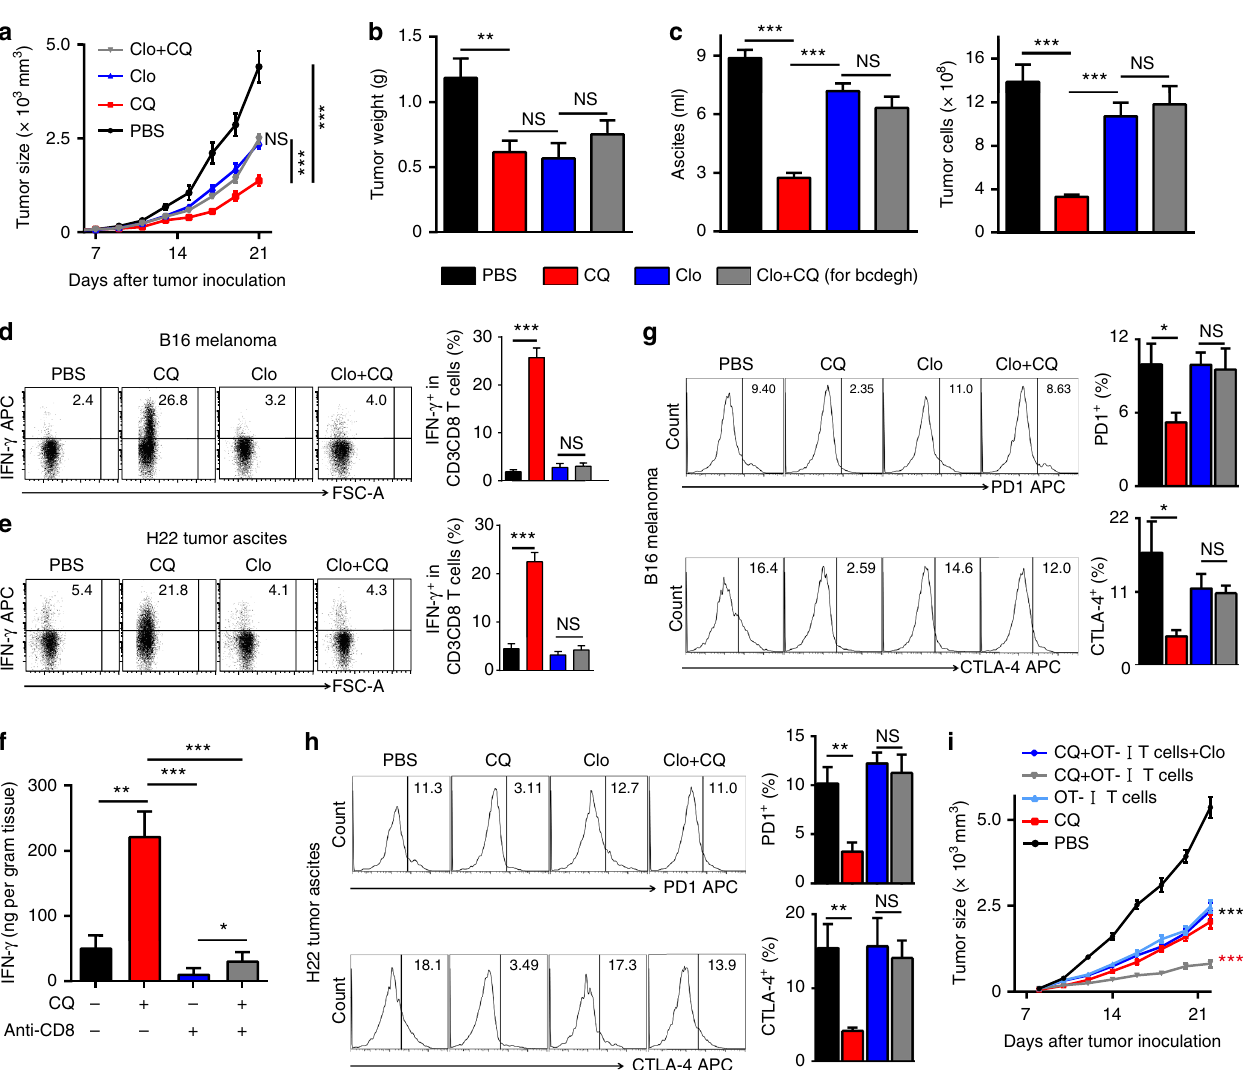
Fig. 2 CQ-induced antitumor T-cell immunity is macrophage dependent. a C57BL/6 mice ( n = 8) bearing subcutaneous B16 melanoma with or without clodronate liposomes treatment were intratumorally injected with PBS or CQ for 2 weeks (Clo: clodronate liposomes). The tumor growth was followed. b BALB/c mice ( n = 6) bearing H22 muscle hepatocarcinoma with or without clodronate liposomes treatment received intratumoral injections of PBS or CQ (Clo: clodronate liposomes). After 1 week of treatment, the mice were killed and the tumor weight was measured by the weight of right thigh minus the left. c BALB/c mice ( n = 6) bearing H22 hepatocarcinoma ascites with or without clodronate liposomes treatment received i.p. injections with PBS or CQ. After 1 week, the mice were killed to measure the tumor ascites volume (left) and the tumor cell number (right). d , e Tumor-bearing mice with or without clodronate liposomes treatment were i.p. injected with PBS or CQ. IFN- γ expression in CD3 + CD8 + tumor-in fi ltrating lymphocytes (TILs) from B16 melanoma d ( n = 6) or H22 hepatocarcinoma ascites e ( n = 6) was analyzed by fl ow cytometry. f B16 melanoma mice ( n = 5) with or without anti-CD8 neutralizing antibody treatment were i.p. injected with PBS or CQ for 1 week. IFN- γ in tumor tissue was measured by ELISA. g , h Tumor-bearing mice with or without clodronate liposomes treatment received i.p. injections with PBS or CQ. Representative fl ow cytometric analysis and quanti fi cation of PD-1 and CTLA-4 in CD3 + CD8 + TILs from subcutaneous B16 melanoma g ( n = 6) and H22 hepatocarcinoma ascites h ( n = 6). i OVA-B16 melanoma-bearing CD45.1 + C57BL/6 mice ( n = 10) were treated with or without CQ, concomitant with adoptive transfer of OVA-speci fi c CD8 + T cells and/or clodronate liposomes treatment. Tumor growth was followed. Black asterisk, PBS compared with CQ, OT-I T cells, or CQ + OT-I T cells + Clo; red asterisk, CQ + OT-I T cells compared with CQ or CQ + OT-I T cells + Clo. Data shown are representative of three independent experiments and error bars represent mean ± SEM. * P < 0.05; ** P < 0.01; *** P < 0.001; NS, not statistically signi fi cant (Student ’ s t